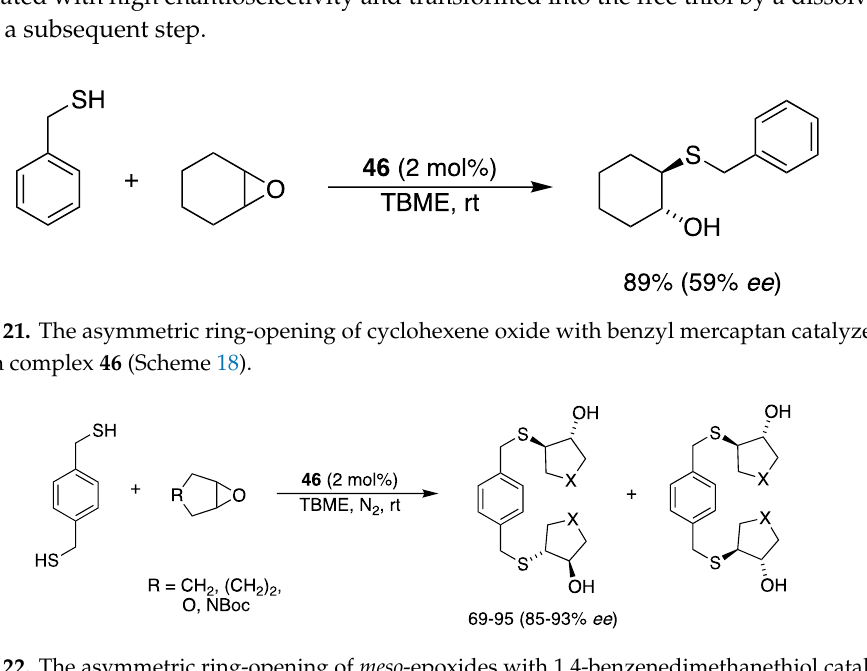
Figure 21. Dimeric Co(II)salen catalyst 48 .